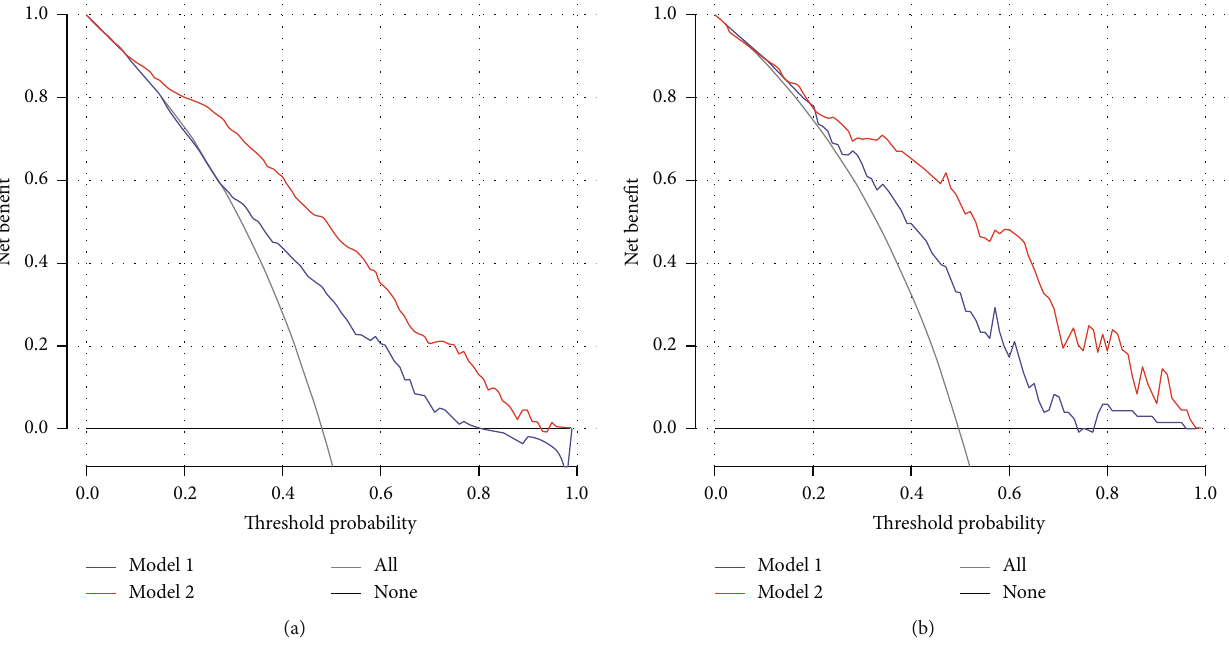
Figure 5: Decision curve analysis of the two models for predicting acute tICH expansion in the (a) development cohort and the (b) validation cohort, respectively. For the two predictive models, the net bene fi t curve is shown. Blue line (model 1) =basic model; red line (model 2) =MLR model; black line=net bene fi t when all the patients are considered as not having acute tICH expansion; light grey line=net bene fi t when all the patients are considered as having acute tICH expansion. The preferred model is the model with the highest net bene fi t at any given